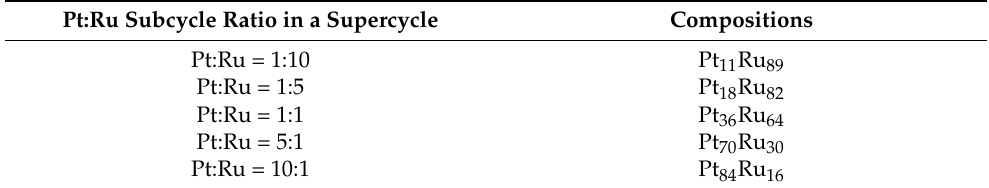
Table 1. A supercycle design and corresponding compositions for PtRu bimetallic alloy thin films. Pt:Ru Subcycle Ratio in a